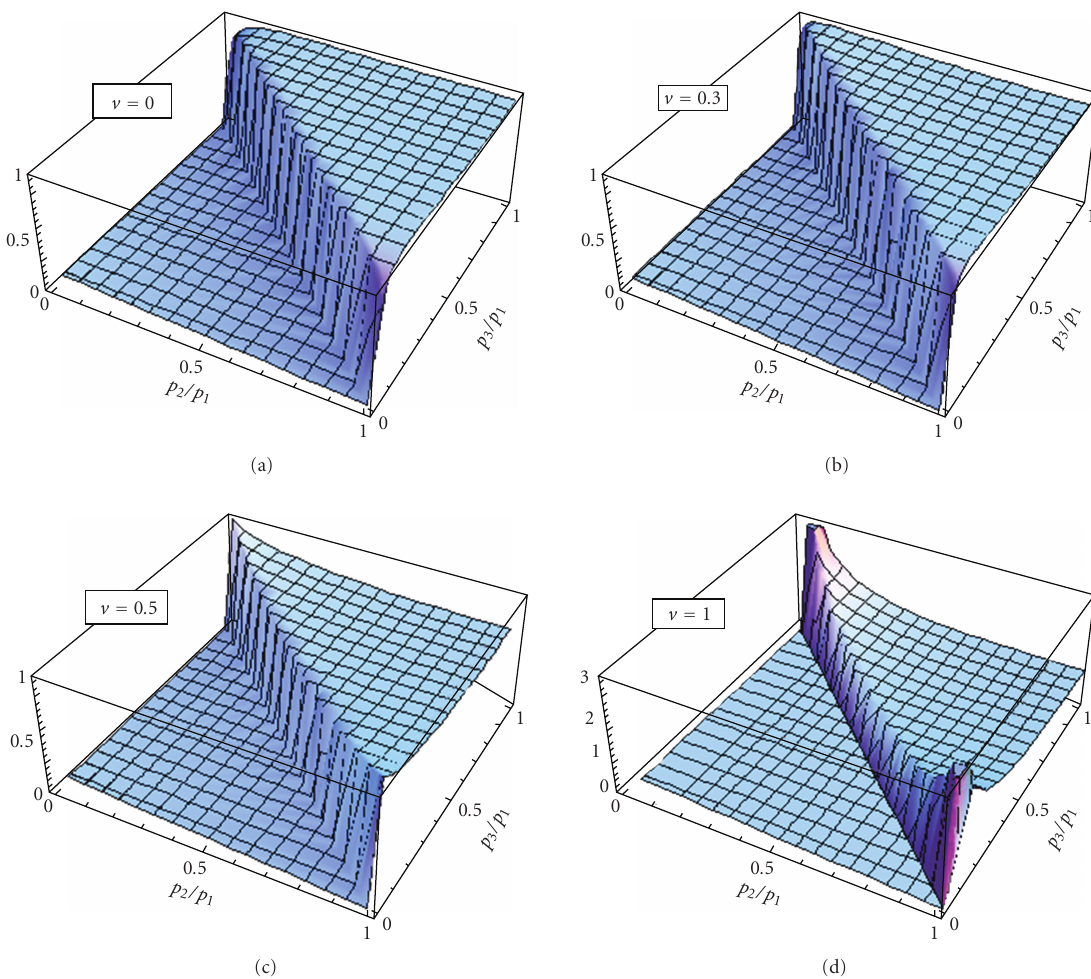
Figure 14: Numerical results for the shapes of bispectra with intermediate forms. We plot S with ν = 0,0 . 3,0 . 5,1. The plot is normalized such that S = 1 for p 1 = p 2 = p 3